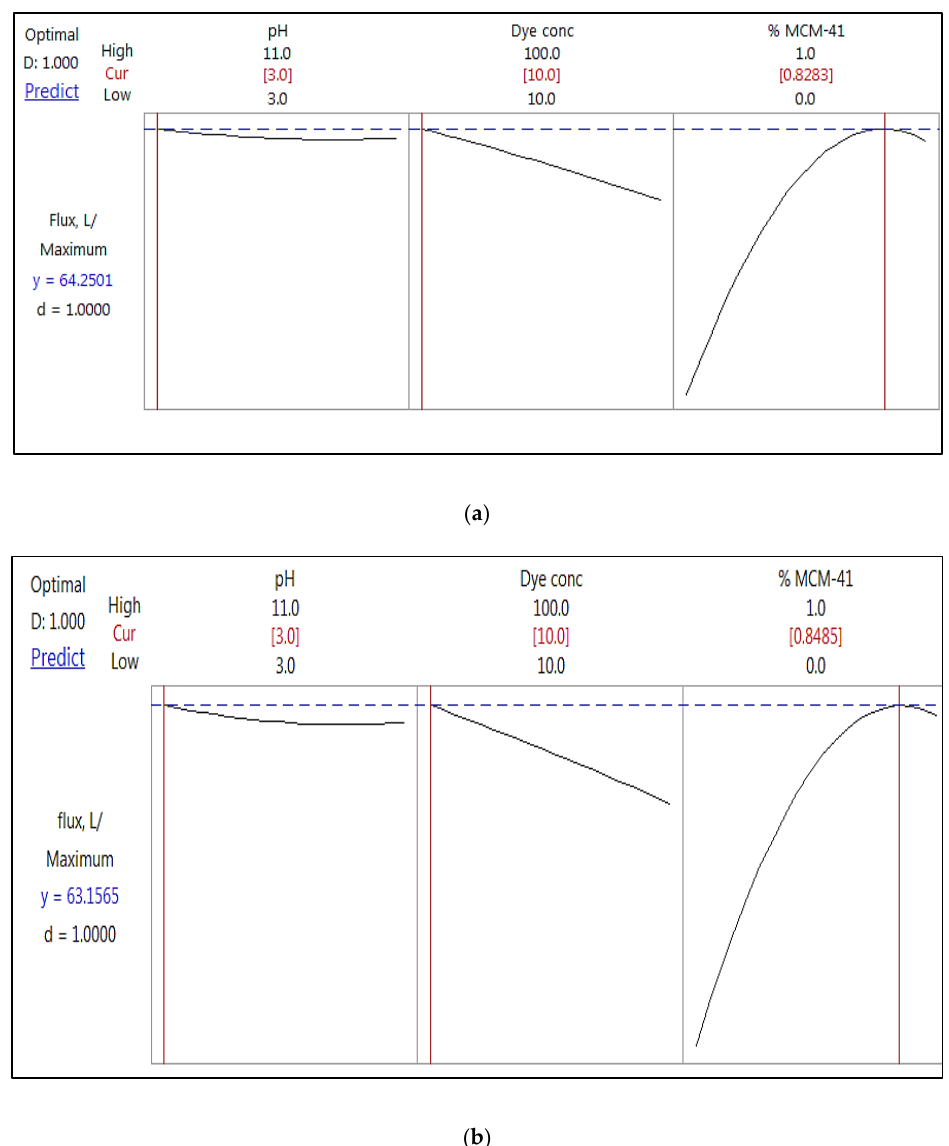
Figure 8. Optimization plot of the process parameters for the maximum permeability for ( a ) AB-210, and ( b ) RB dyes.